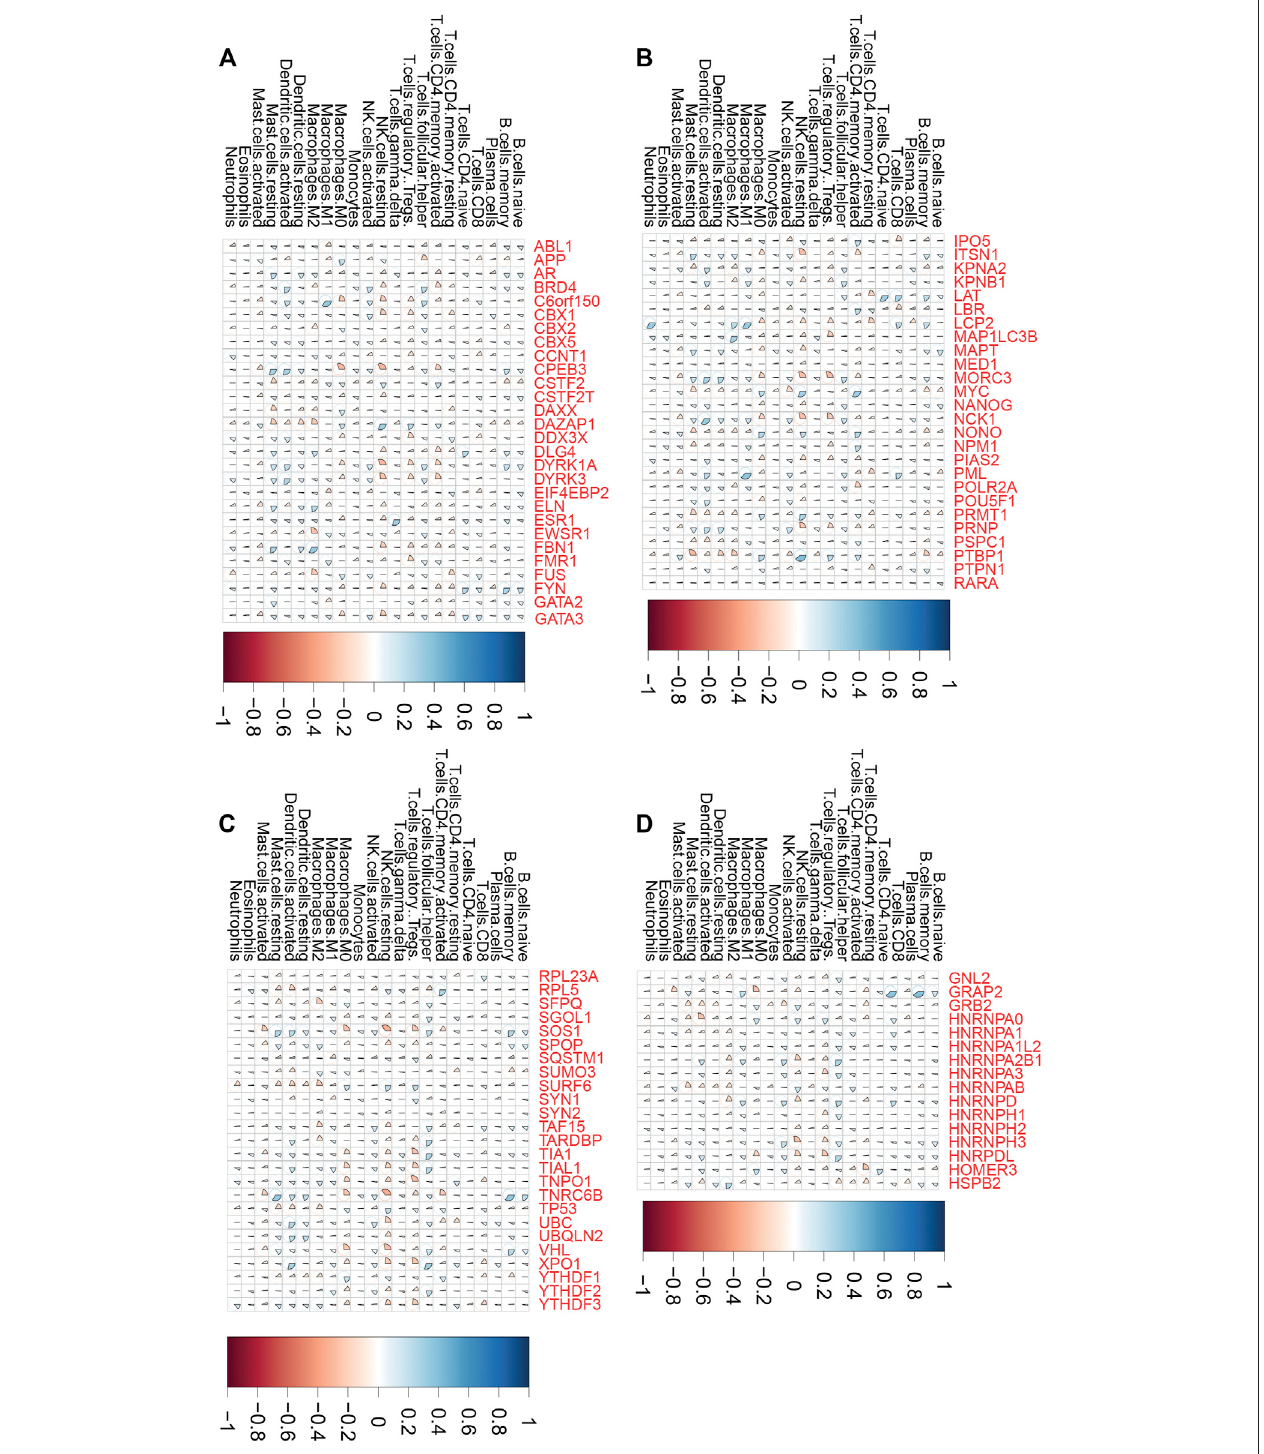
FIGURE 6 | LLPS regulators were signi fi cantly related to tumor immune in fi ltration in digestive system neoplasms. (A – D) The correlation of LLPS gene expression with percentage of immune cell predicated by CIBERSORT.